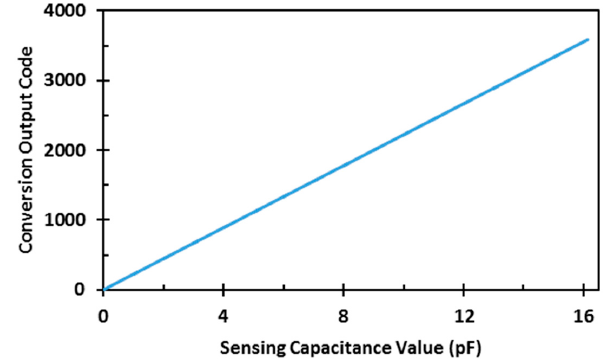
Figure 8. Measured transfer function of readout circuit.